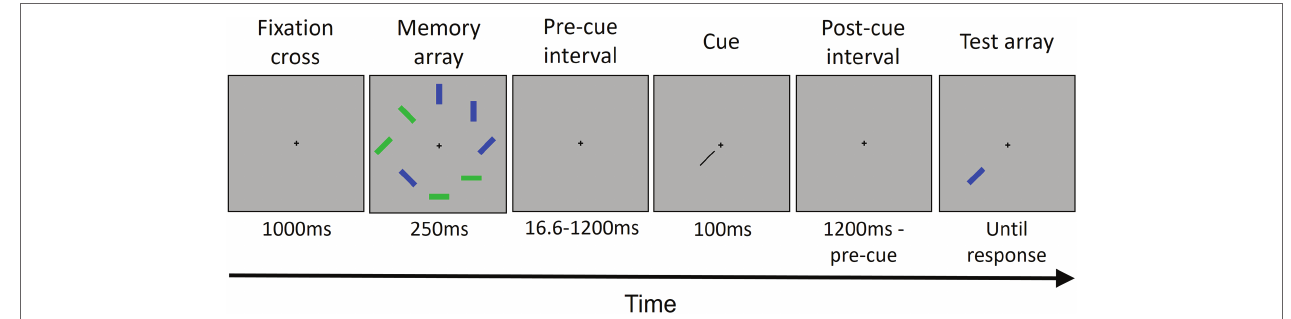
FIGURE 1 | The trial structure. Each trial started with the presentation of a fixation cross, followed by the memory array that included eight colored rectangles. After a variable interval (see Methods Section for details), a cue was presented, pointing to one out of the eight locations occupied previously by one of the rectangles. Then, after another interval, the rectangle in the cued location was presented as a probe. The rectangle remained displayed until the participant gave a response. In this example, the cued rectangle changed its